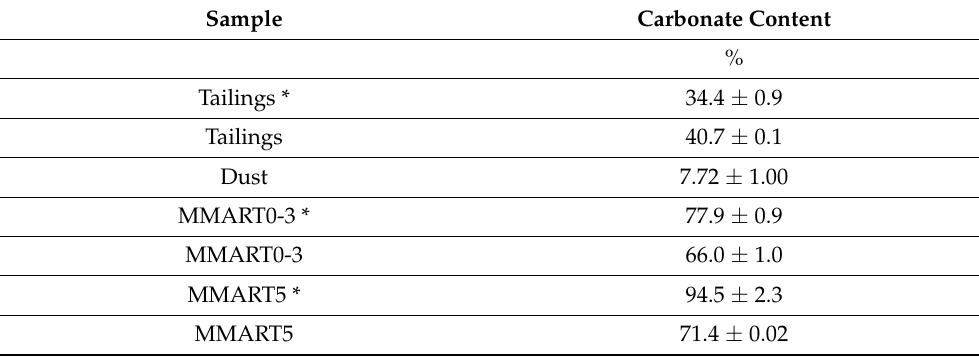
Table 1. Content of carbonate components in the tailings, dust, Mala Martinska Cove sediment (depth 0–3 cm and 5–7 cm) and Mala Stupica Cove sediment samples in bulk and <0.063 mm